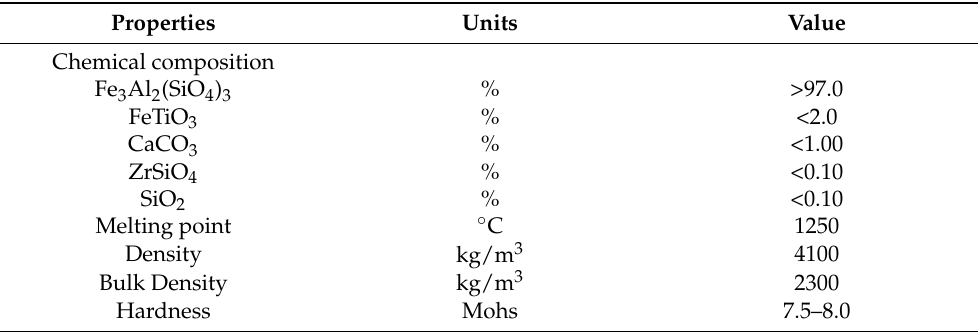
Table 1. Detailed properties of Australian alluvial garnet